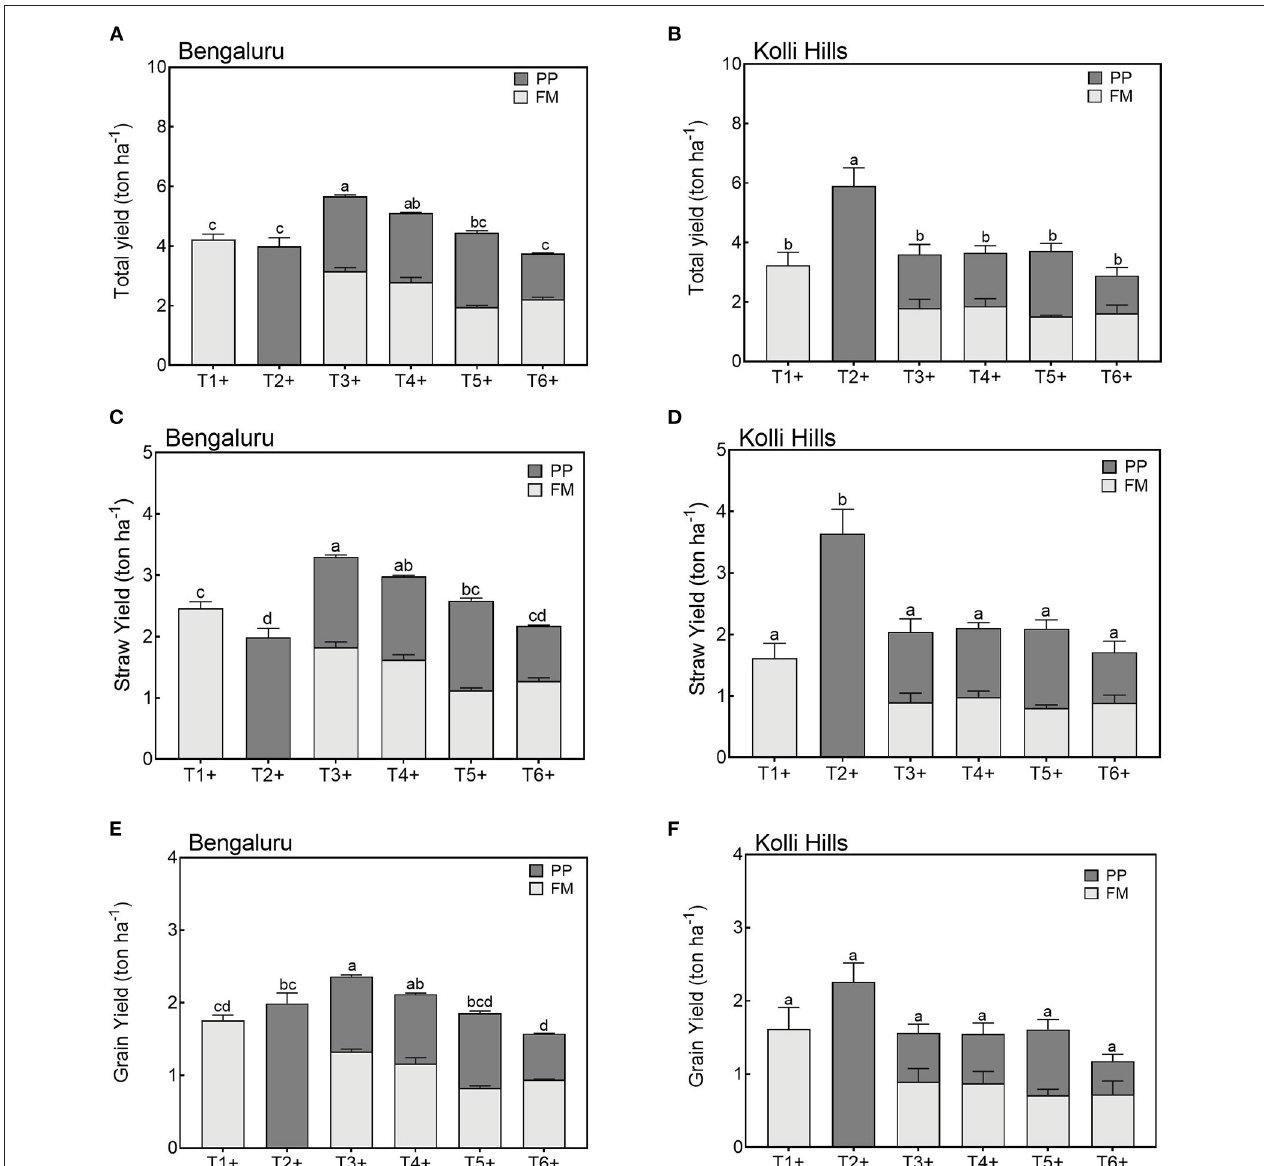
FIGURE 2 | Total biomass, straw and grain biomass of FM and PP at Bengaluru (A,C,E) and Kolli Hills (B,D,F) during year 2016/17. Bars represent the average of four replicates with one standard error of mean. One-Way ANOVA followed by Tukey‘s test ( post-hoc test) was used for the combined biomass of FM and PP, separately for each site, and values with same letters are not significantly different from each other at p >